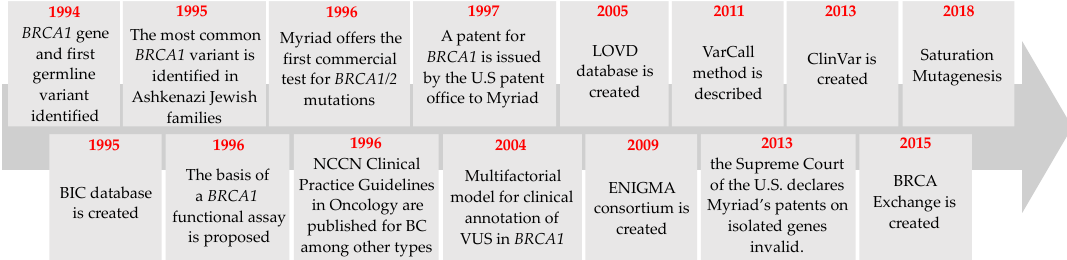
Figure 2. BRCA1 timeline. BRCA1-related events in the last three decades. Depicted events are discussed throughout this review.